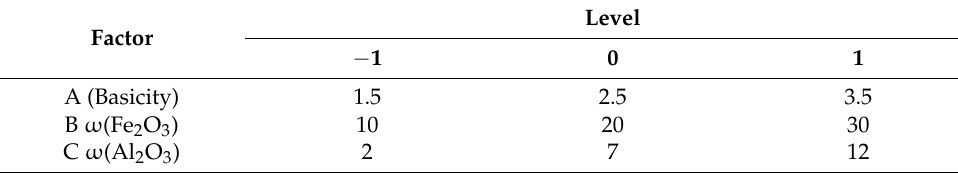
Table 3. Box–Behnken analysis factors and levels.